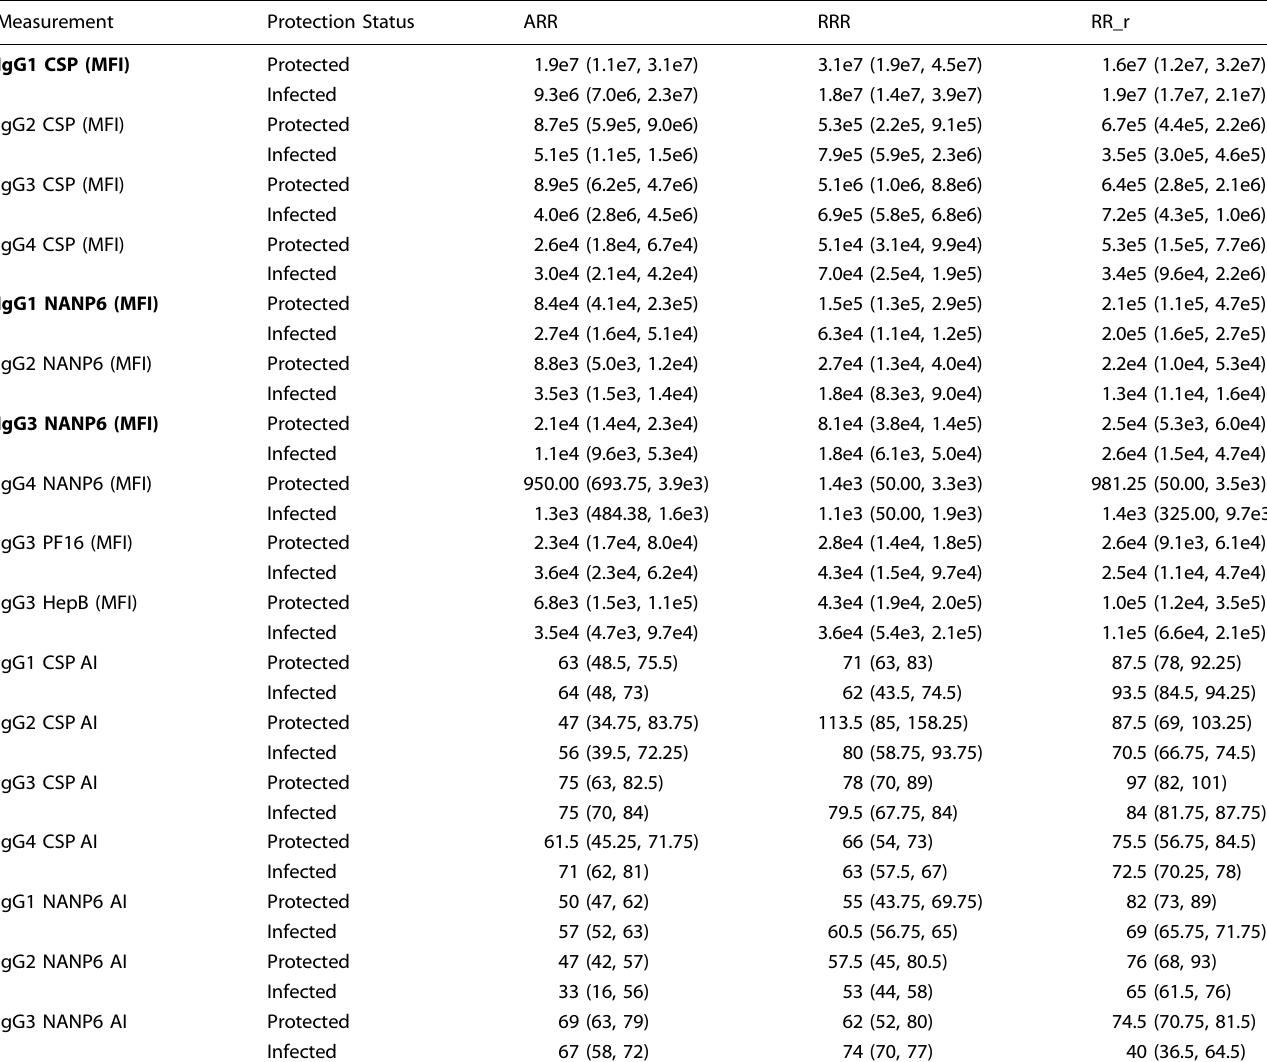
The median and 25 th to 75 th percentiles, or interquartile range (IQR) indicated in parentheses, of magnitude (MFI x Dilution Factor) and AI (%) are shown. RRR summary statistics represent the standard dose regimen groups from both studies combined. AI is reported only for positive responses. Top univariate predictors are in seven univariate predictors of protection status with odds ratios 0.021, Fig. 2 and Table 4). IgG3 NANP6 magnitude was 4.5-fold higher in RRR vaccinees and 1.8-fold higher in ARR vaccinees (Fig. 3c and Table 1), with an OR of 1.73 (95% CI (1.06, 3.01), p = 0.037 and FDR p = 0.117, Fig. 2 and Table 4). Median response differences for IgG1 CSP, IgG1 NANP6 and IgG3 NANP6 measure- ments were smaller between protected and infected RR_r vaccinees (fold differences in medians < 1.2). Four of the seven predictors were total serum antibody measurements, as measured by BLI, that associated with protec- tion across the study arms (Fig. 4). CSP AUC diss had an OR of 2.49 (95% CI (1.42, 4.83), p = 0.003 and FDR p = 0.034, Fig. 2 and Table 4) and was 1.7 fold higher in ARR protected vaccinees, but the medians were similar for protected and infected RRR and RR_r vaccinees (Fig. 4a and Table 3). Protected vaccinees had 1.3 to 1.7 fold higher NANP6 AUC diss (Fig. 4b and Table 3), with OR = 2.50 (95%CI (1.28, 6.01), p = 0.021 and FDR p = 0.091, Fig. 2 and Table 4), and 1.3 to 1.8 fold higher NPNA3 AUC diss (Fig. 4c and Table 3), with OR = 2.00 (95%CI (1.18, 4.03), p = 0.025 and FDR p